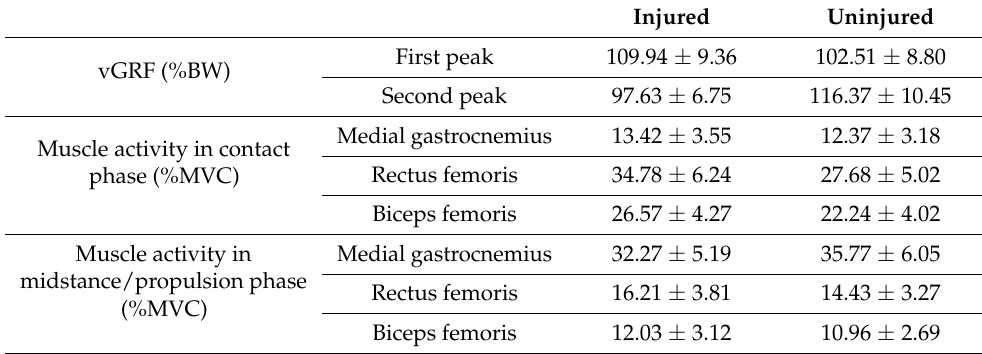
Table 1. Mean and standard deviation of vertical ground reaction force (vGRF) and muscle activity.